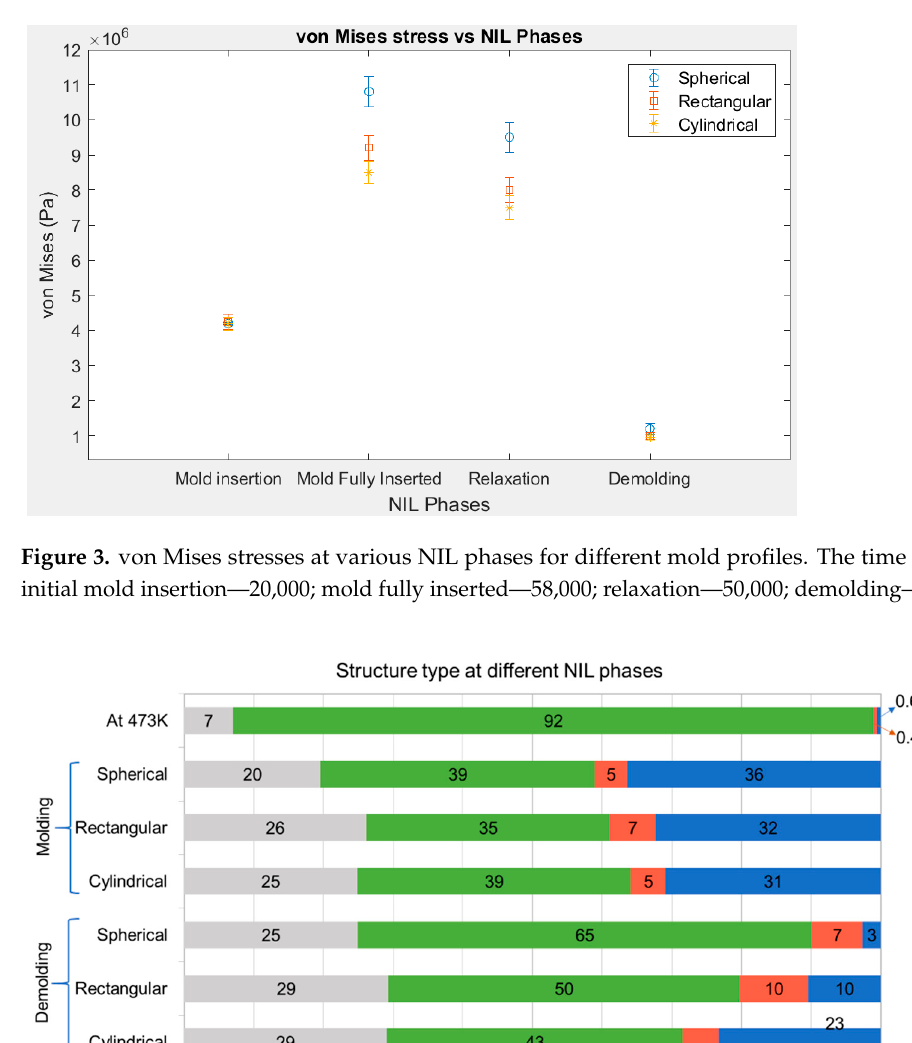
Figure 2. von Mises stresses during the NIL process using a spherical mold profile. Time steps for each phase of NIL: ( a ) 50,000, ( b ) 38,000, ( c ) 50,000, and ( d ) 160,000.